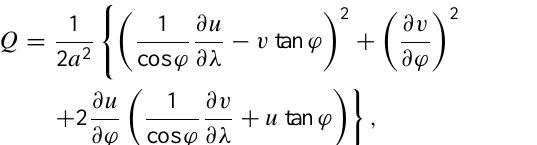
shows variations of MetO temperatures (top panel), merid- ional (NS, middle panel) and zonal (EW, bottom panel) wind components averaged around the 60 ◦ N (solid line) and 70 ◦ N (dotted line) latitudinal circles at the 10 hPa pressure level ( ∼ 32 km), for the time interval from October 2004 (start- ing from day number 275) until the end of March 2005 (day number 456). The MetO temperatures (top) decrease until the end of December (day number 366) down to 202 K and 180 K at 60 ◦ N and 70 ◦ N, respectively, and exhibit similar temporal variations at both latitudes, with temperatures aver- aged over 70 ◦ N being lower than those averaged over 60 ◦ N.